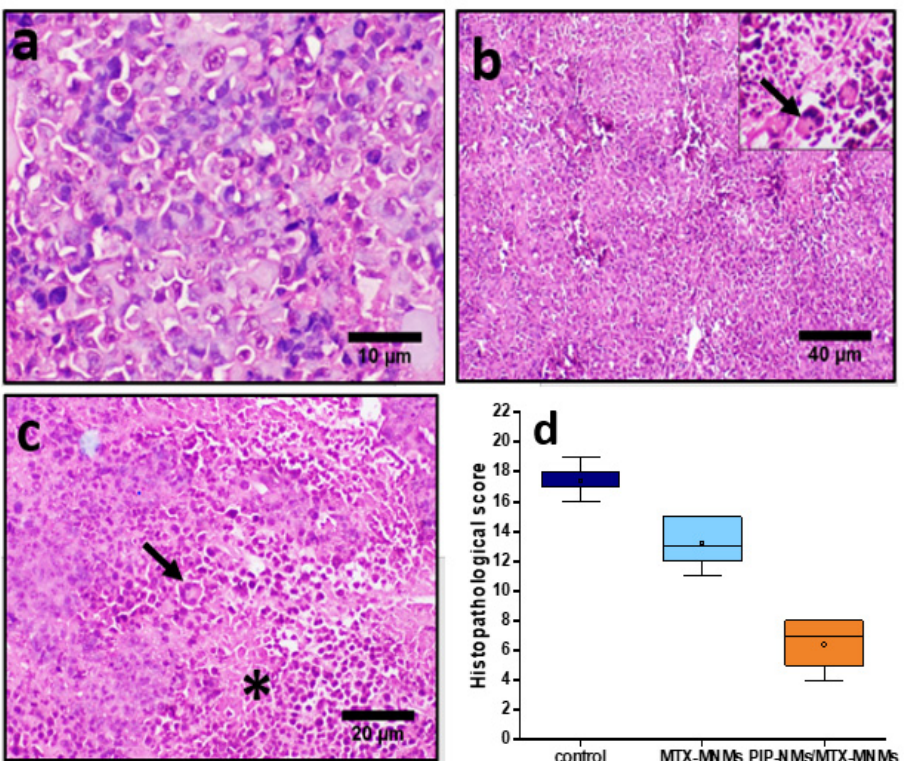
Figure 11. Assessment of muscular tissue inoculated with Ehrlich ascites tumor cells and stained with H&E of the ( a ) control group, ( b ) MTX-MNMs-treated group, ( c ) PIP-NMs/MTX-MNMs-treated group and ( d ) the area (%) analysis of the positive reaction. Symbols on the figure are revealed as follows: black arrow (giant cells) and star (coagulative necrosis).